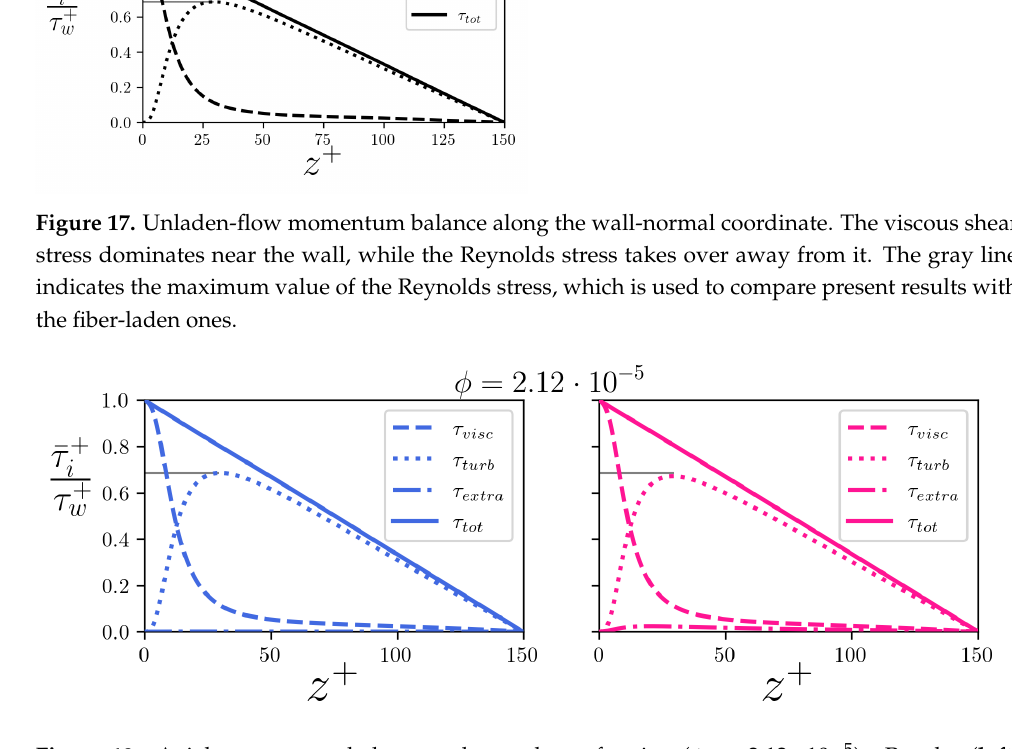
Figure 18. Axial momentum balance at low volume fraction ( φ = 2.12 · 10 − 5 ). Panels: ( left ) St + n = 0.01; ( right ) St + n = 10 .